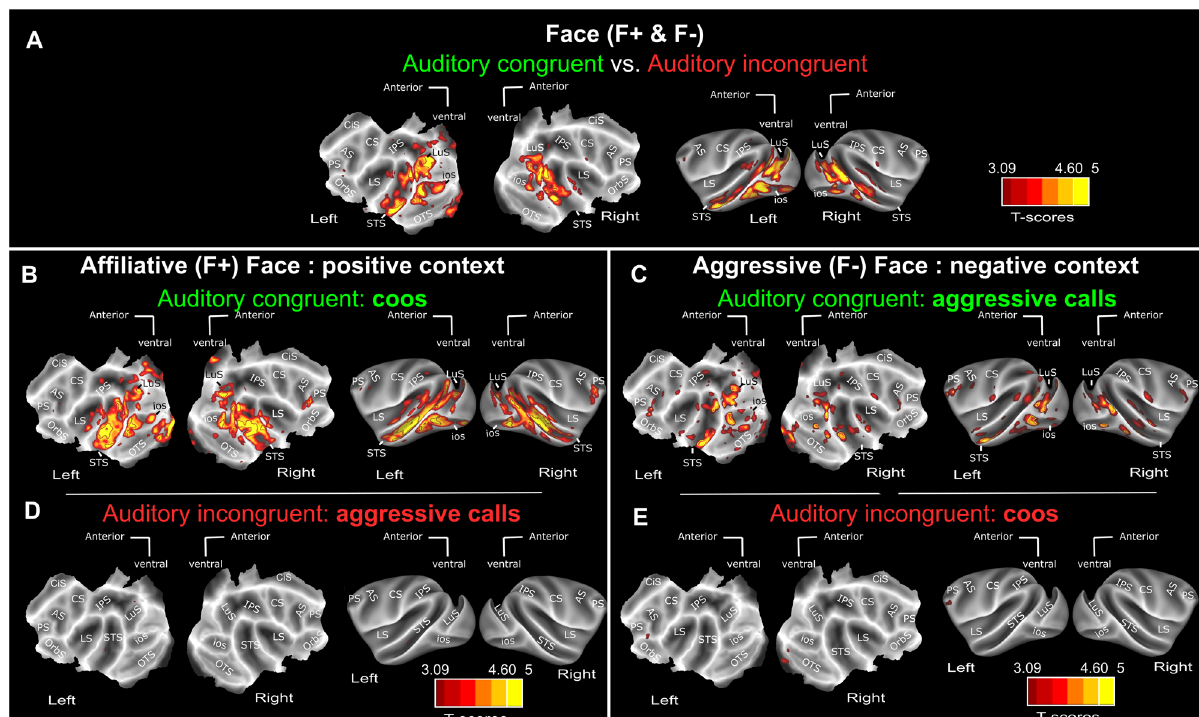
Fig. 3 | Auditory activations depend on semantic congruence with visual con- text. A Whole-brain activation maps of the F+ (face af fi liative) and F − (face aggressive) runs, for the auditory congruent vs auditory incongruent (relative to the visualcontext) contrast. Whole-brain activation map for the F+(faceaf fi liative) ( B ) auditory congruent (coos, dark green, AC vs. Fx) and ( D ) auditory incongruent (aggressivecalls,darkred,AIvs.Fx)conditions.Whole-brainactivationmapforthe F − (face aggressive) ( C ) auditory congruent (aggressive calls, green, AC vs. Fx) and